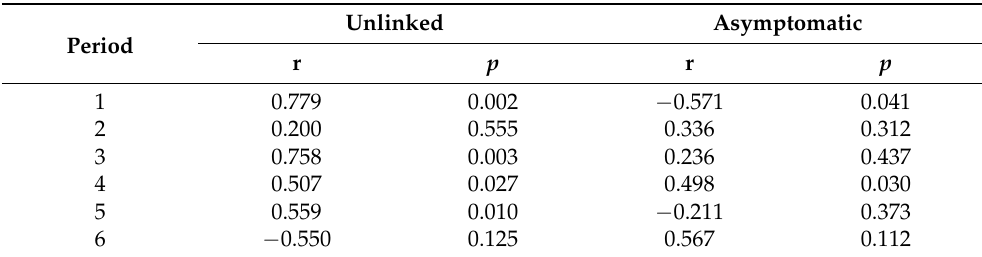
Table 1. Spearman correlation coefficients r for unlinked and asymptomatic cases vs. confirmed cases with p values (See Table S2 for the linear